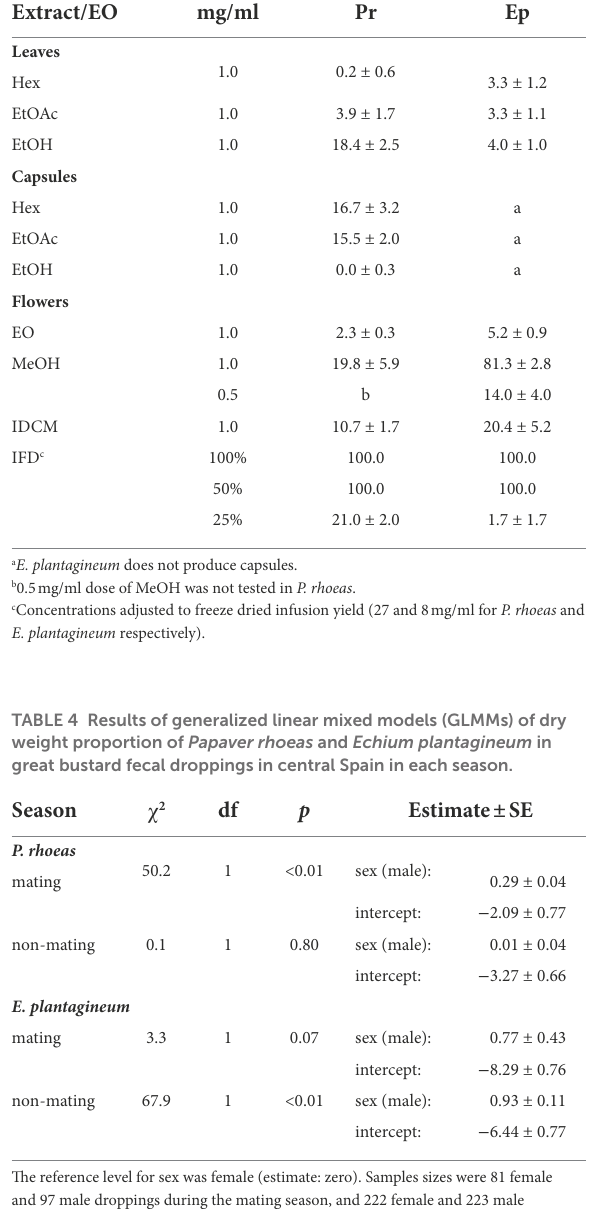
The reference level for sex was female (estimate: zero). Samples sizes were 81 female and 97 male droppings during the mating season, and 222 female and 223 male droppings during the non-mating